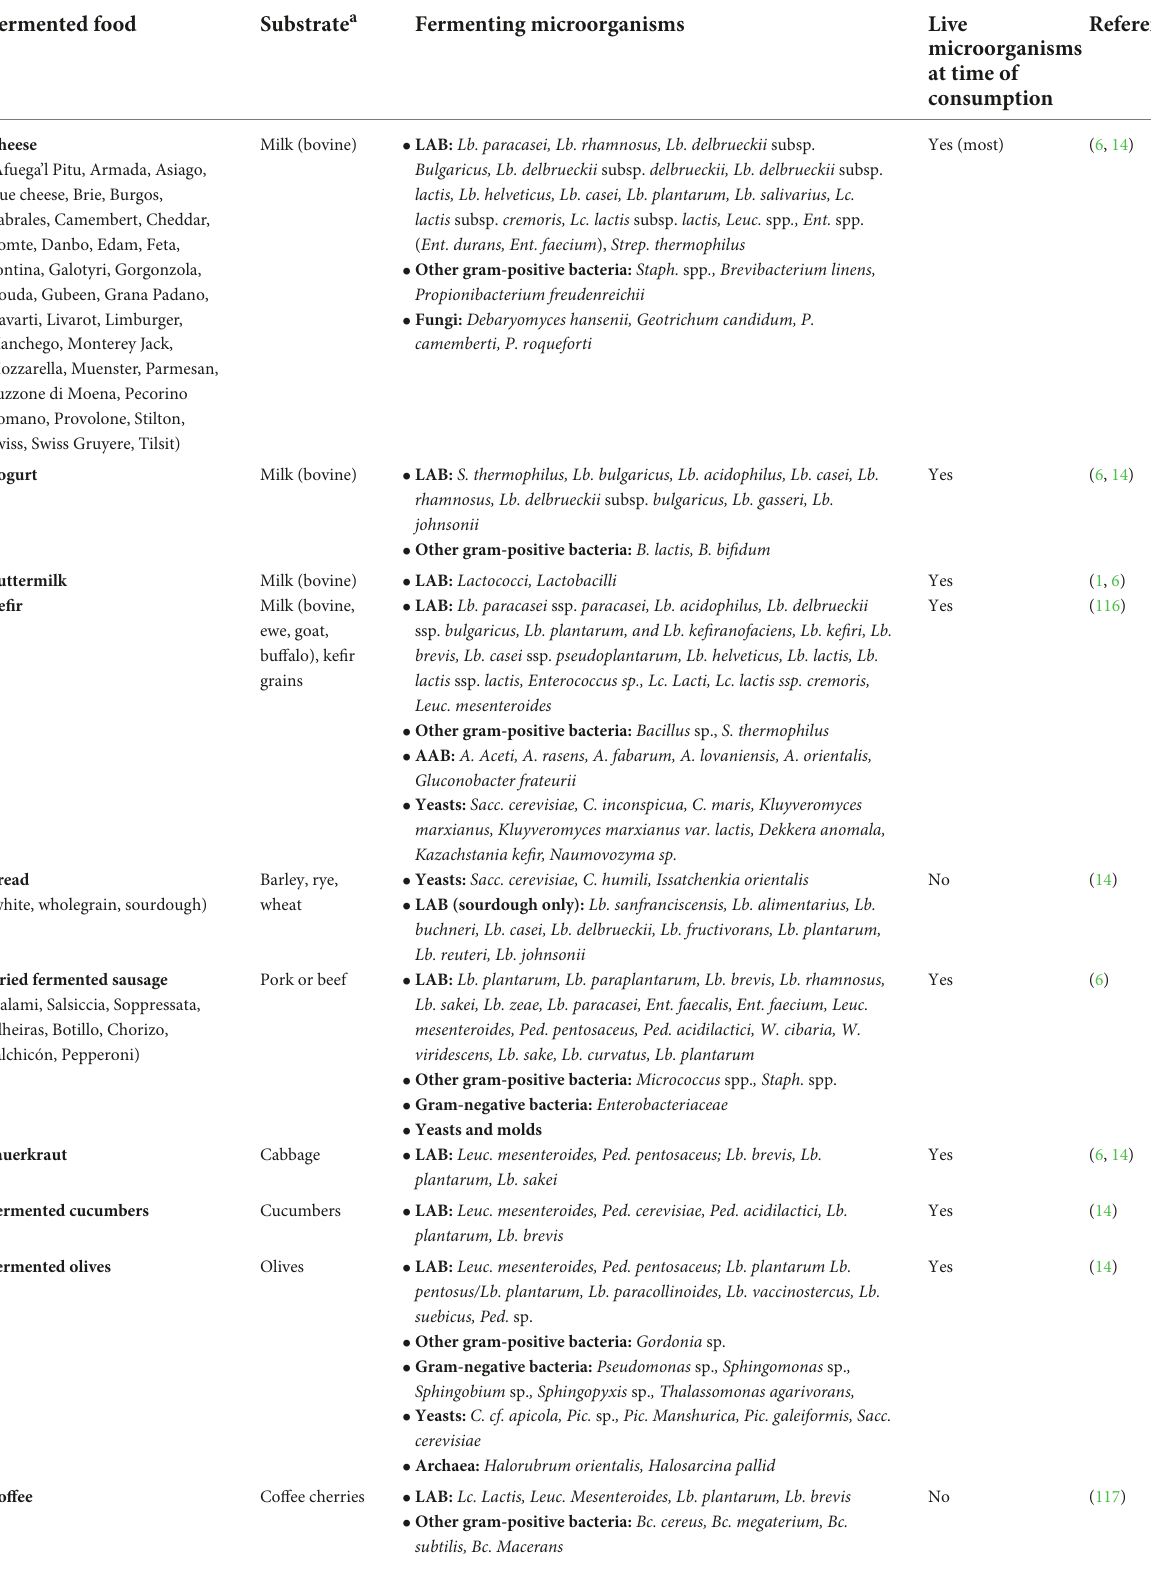
TABLE 2 Substrates and microorganisms of predominant fermented foods consumed in European